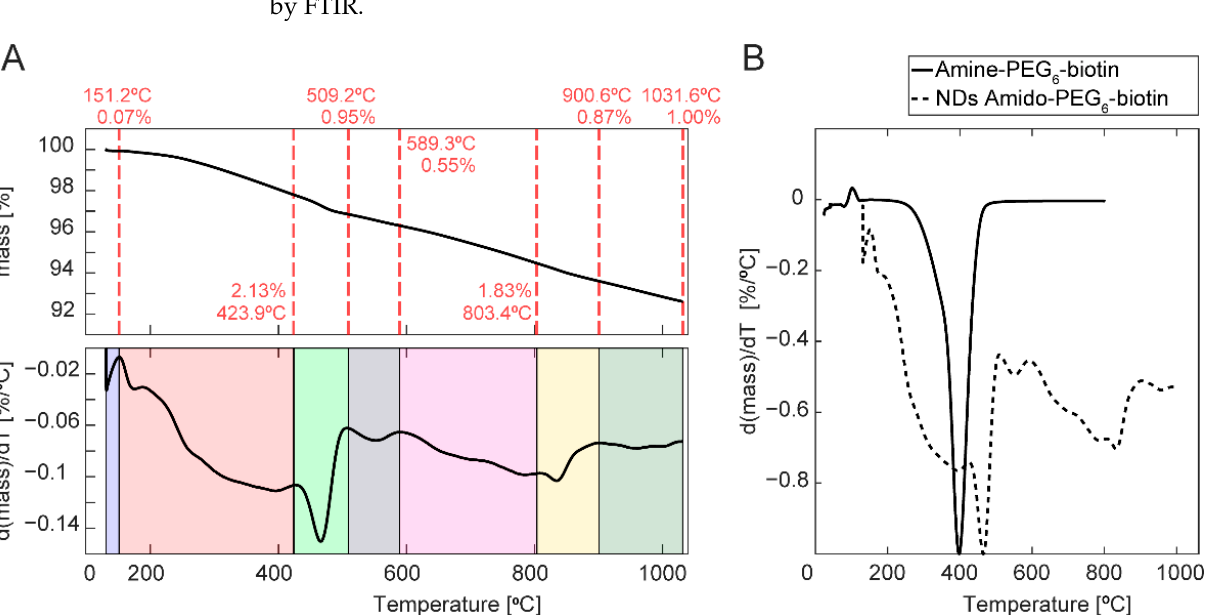
Figure 3. Thermogravimetric analysis of FND–amido–PEG 6 –biotin coupling efficiency. ( A ) TGA profile (top) and DTG (bottom) curves of FND–amido–PEG 6 –biotin. ( B ) DTG curves of FND–amido–PEG 6 –biotin (dashed) and free amine–PEG 6 –biotin (solid).